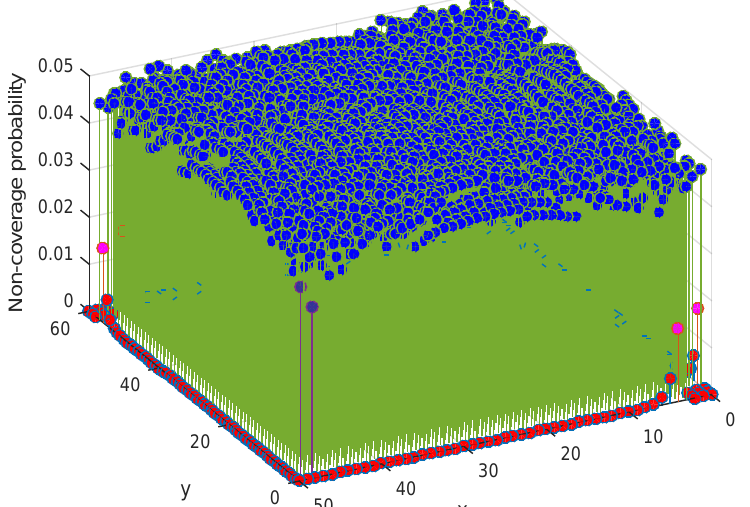
Figure 12. Non-CP for CI ER,5% (0..60, 0..50, 60,